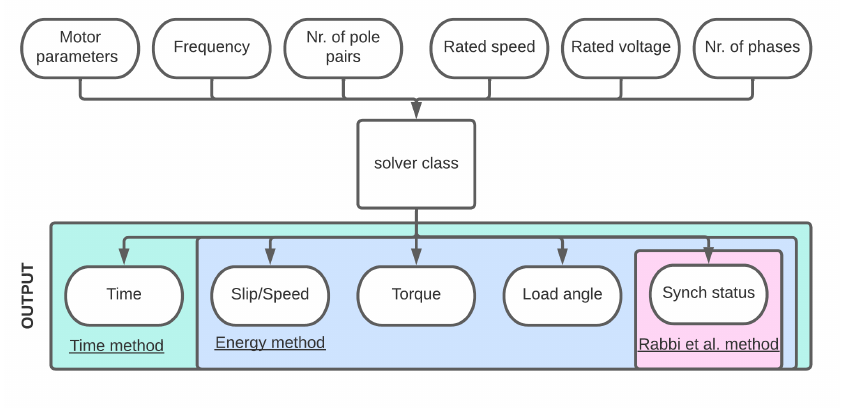
Figure 14. Input and output parameters managed by solver